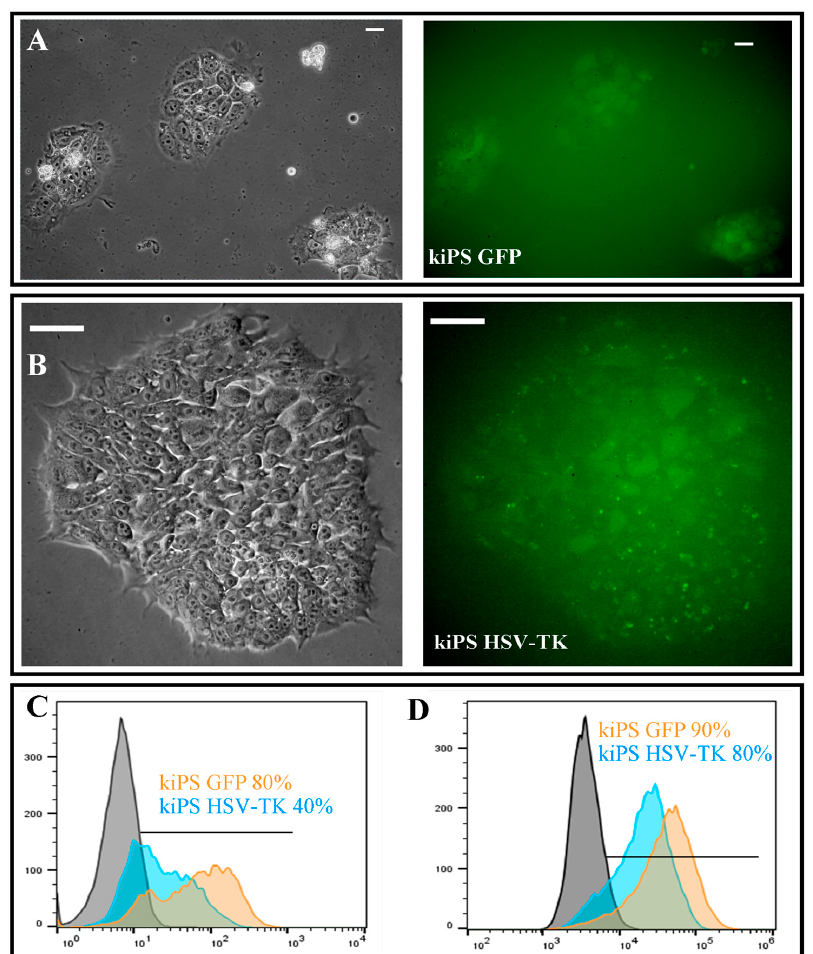
Figure 4. Genetic modification of kiPS cell lines. Genetically modified kiPS cell line express: GFP ( A ); or GFP and HSV-TK ( B ). ( C ) Purity of genetically modified cell lines after antibiotic selection analyzed by flow cytometry. ( D ) Purity of genetically modified cell after cell sorting. ( A ) Magnification 200×, white bars represent 50 µm; and ( B ) magnification 400×, white bars represent 50 µm.